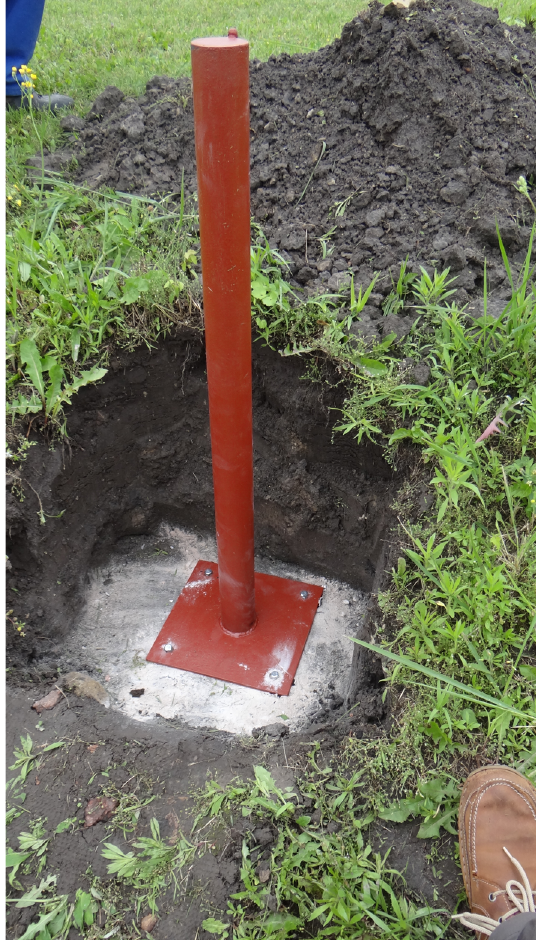
Figure 12: The structure of controlled point whilst fixing to the upper surface of the roof slab.